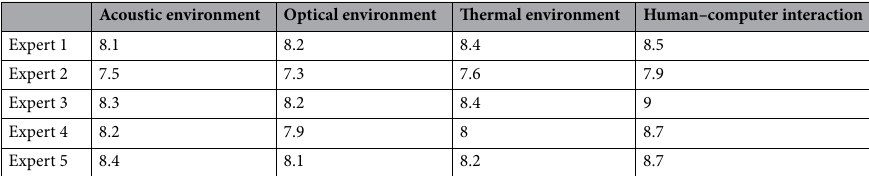
Table 1. Level 1 index score value.